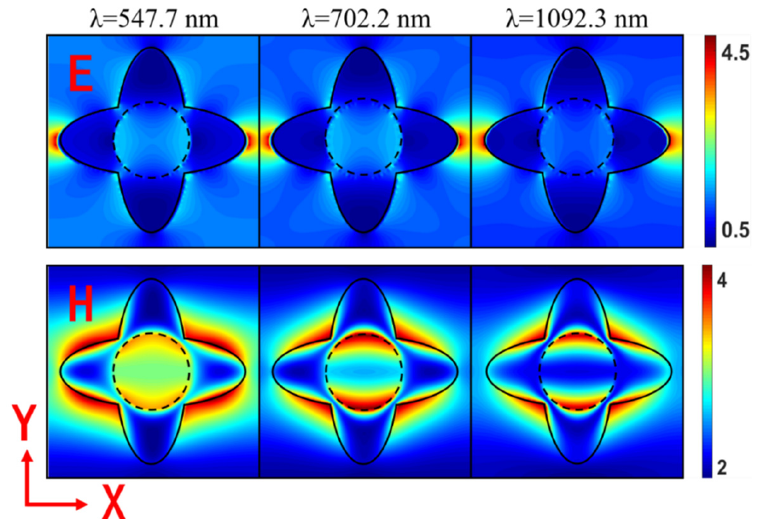
Figure 4. Electric and magnetic field distribution at three resonant wavelengths in the XOY direction.